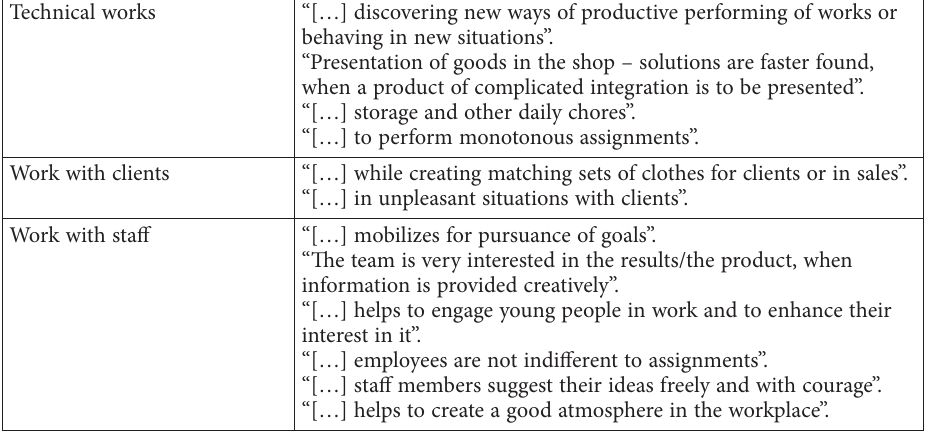
Table 1. The activities in fashion retail industry, which require creativity (source: created by authors) Technical works